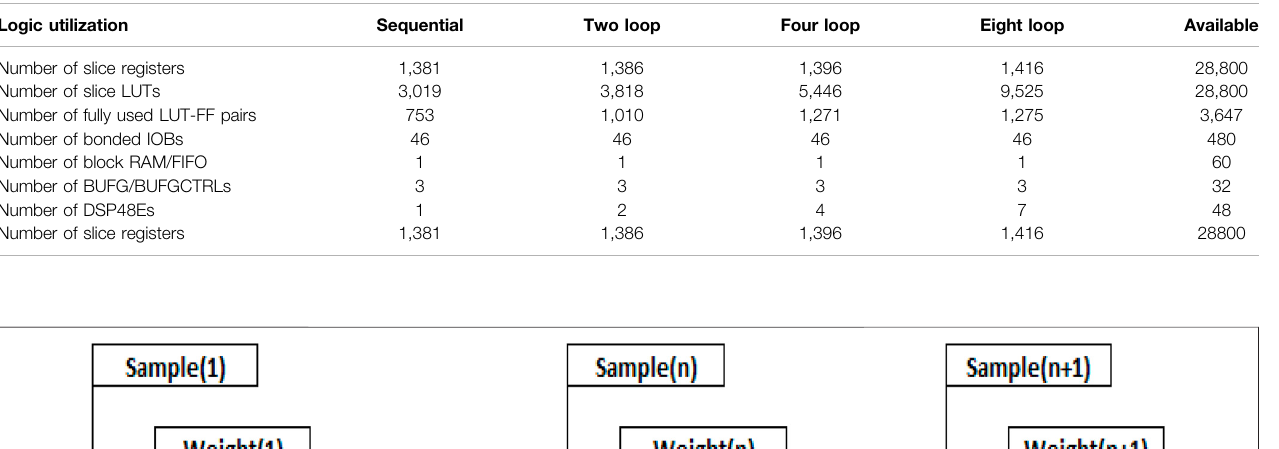
TABLE 4 | The resources utilization for the implemented architecture of Sequential and parallel resampling on xc5vlx50t-3-ff1136 chip.